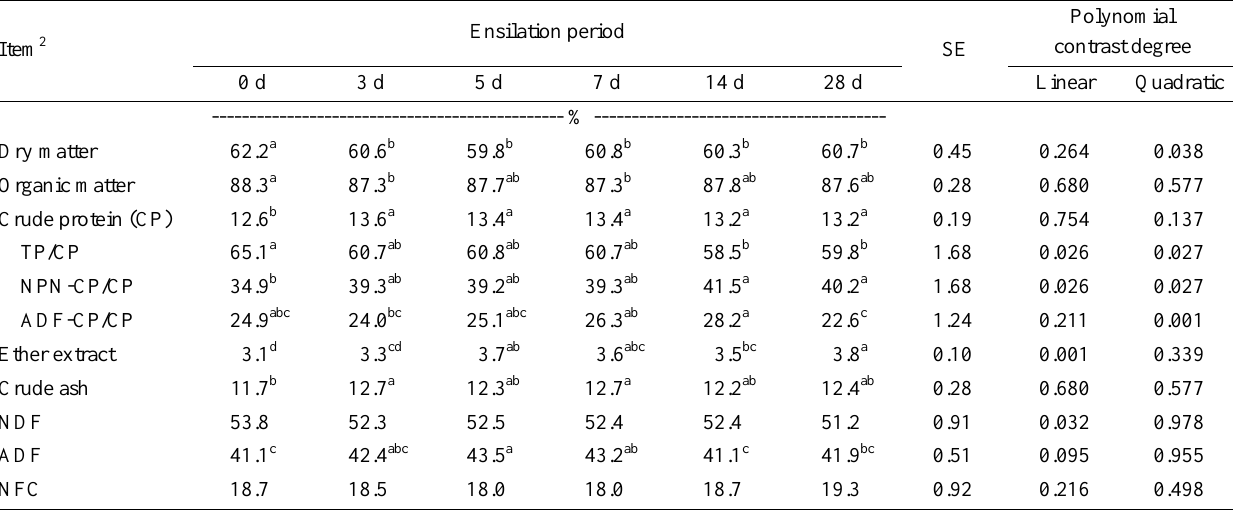
Table 2. Changes in chemical composition (DM basis) of the by-product feed-based silage following different lengths of ensilation 1